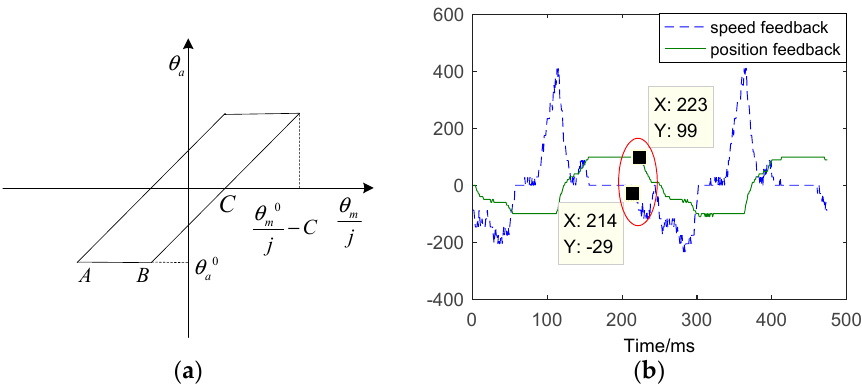
Figure 3. The effect of backlash. ( a ) Characteristic of backlash. ( b ) The tracking results of time-delay between speed feedback and position feedback.